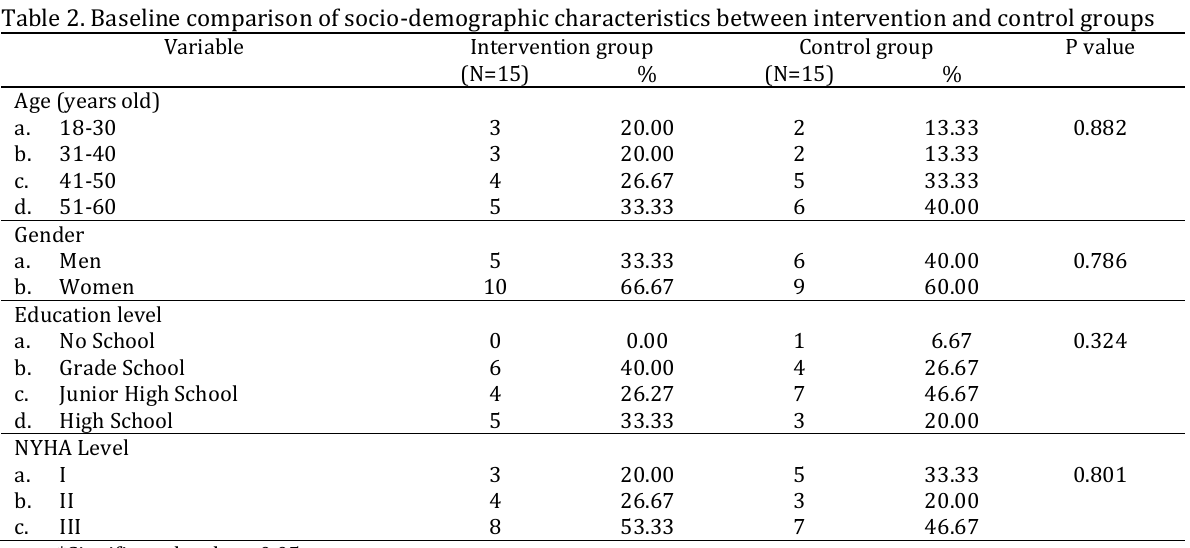
Table 2. Baseline comparison of socio-demographic characteristics between intervention and control groups